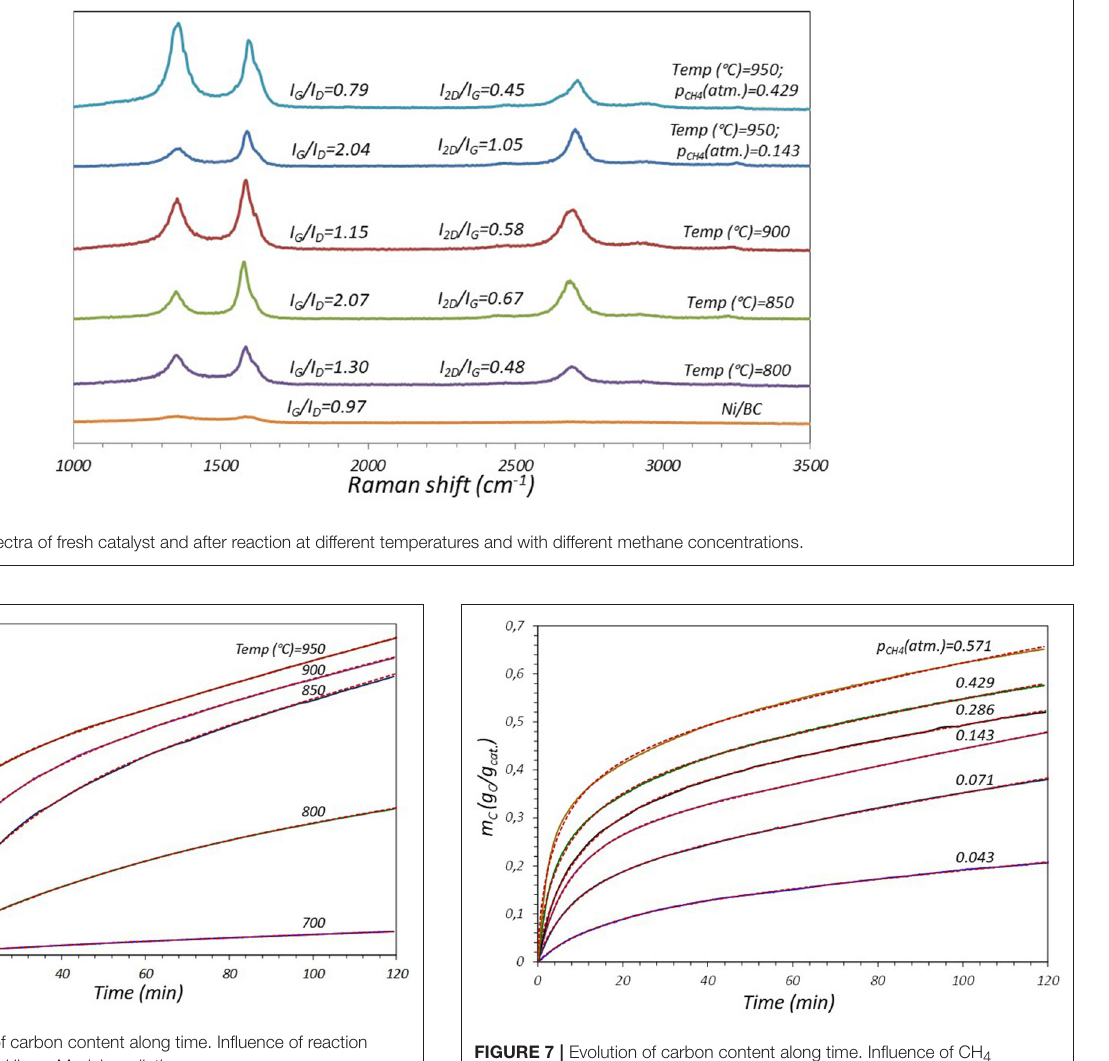
FIGURE 7 | Evolution of carbon content along time. Influence of CH 4 concentration. Red dotted lines: Model